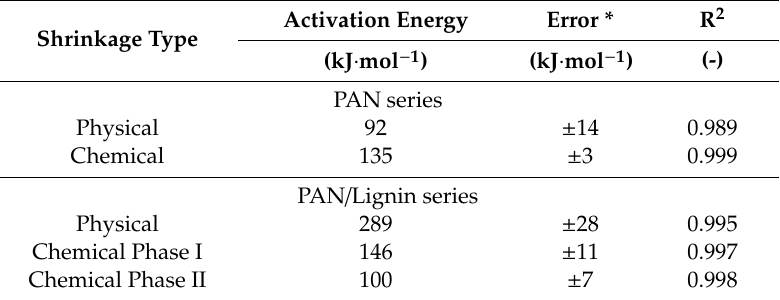
Table 6. Activation energy of the physical and chemical shrinkage of the neat PAN fibers and PAN / lignin fibers calculated from the Kissinger plot at di ff erent heating rates under